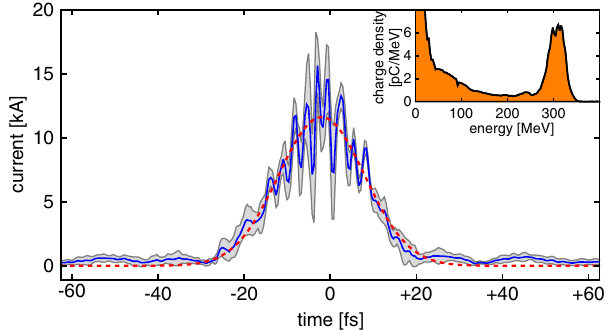
FIG. 21. Features a reconstructed ultrashort Laser-wakefield accelerated electron bunch based on the CTR spectrum, see Fig. 19, the electron spectrum, bunch charge and bunch diver- gence acquired at single-shot. The electron bunch features ð 9 . 78 (cid:3) 0 . 77 Þ fs rms-bunch duration, ð 9 . 40 (cid:3) 0 . 66 Þ kA peak current and sub-structure with ∼ 3 . 0 fs characteristic